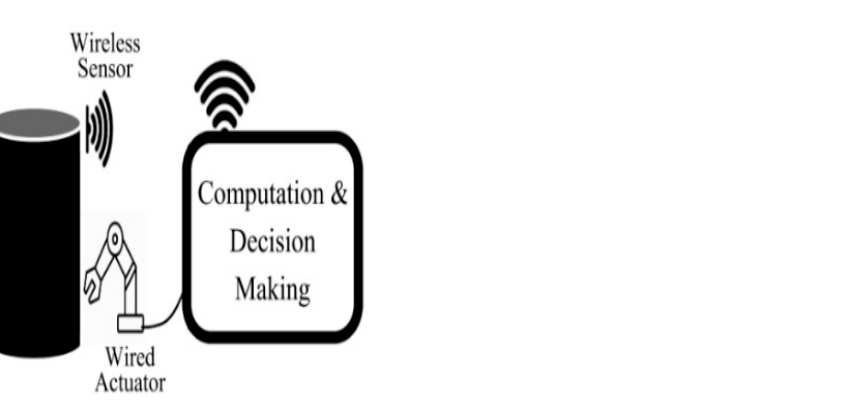
Figure 5 . Overall Architecture of CPS [66]. Reproduced with permission from Mohamed, M.A.; Kardas, G.; Challenger, M; 2021.